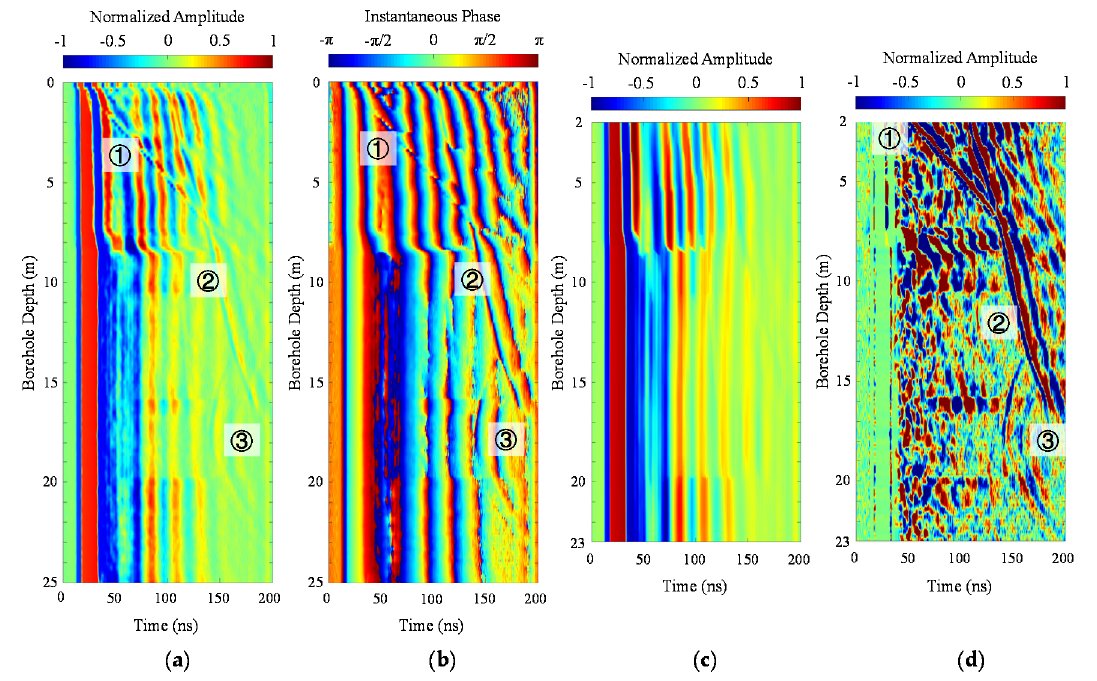
Figure 4. Original single borehole GPR detection data of controlled horizontal borehole experiment: ( a ) processed radar data; ( b ) instantaneous phase; ( c ) removed wave profile using median filtering; ( d ) median filtered wave. Two meters at the top and bottom are removed during median filtering.